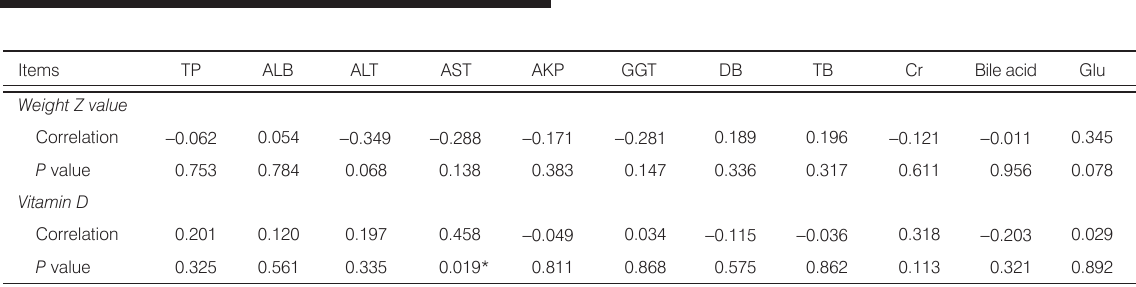
Table 4. Correlation between weight Z value, Vitamin D level, and liver function. Note: TP: total protein; ALB: albumin; ALT: alanine transaminase; AST: aspartate transaminase; AKP: alkaline phosphatase; GGT: gamma-glutamyl transpeptidase; DB: